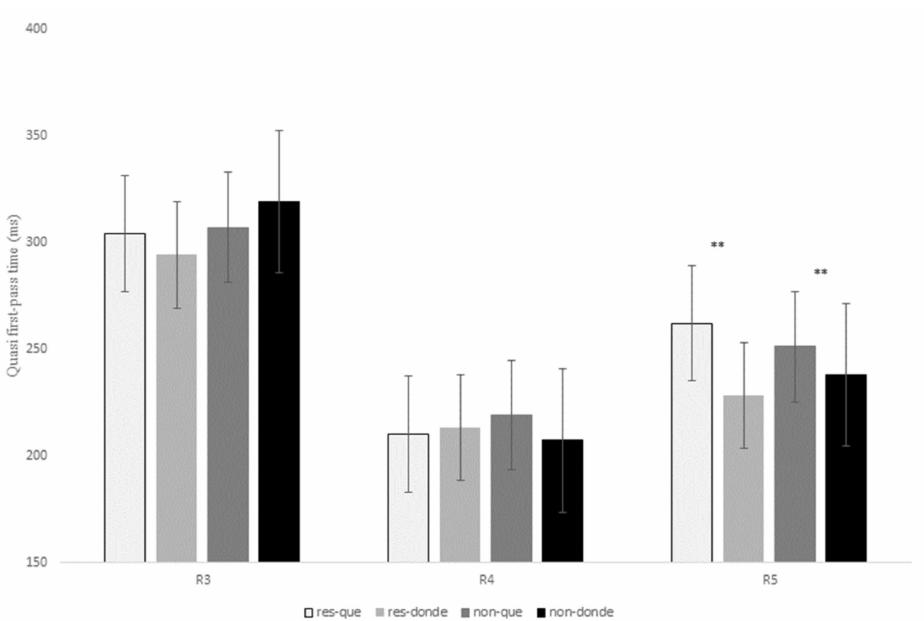
Figure 9. Reading time in milliseconds for the quasi-first-pass reading time at regions 3, 4, and 5 for the contrast of que versus donde in restrictive and non-restrictive RCs. Asterisks indicate that an effect is significant at p < 0.01.